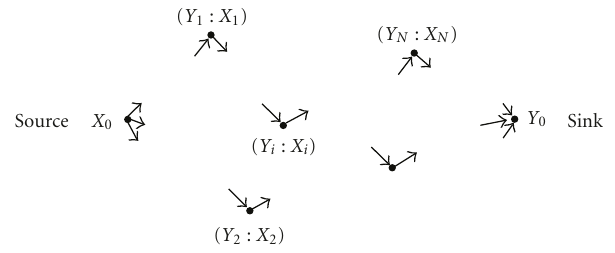
Figure 1: General discrete memoryless relay network [4, Figure